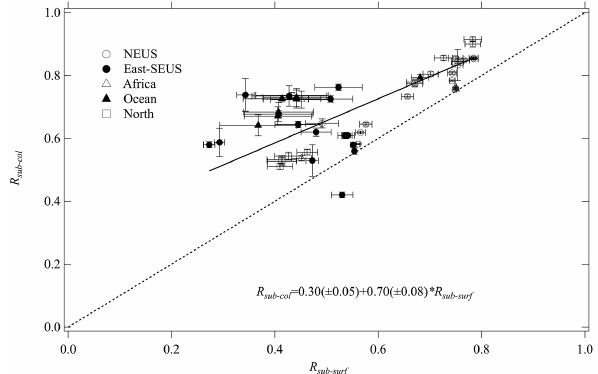
Figure 5. Scatterplot of column and near-surface sub-µm scattering fraction of light. The solid line depicts regression as described in Sect. 2.3.6, values in parentheses correspond to standard errors, and r 2 = 0 . 50. The dashed line is the 1 : 1